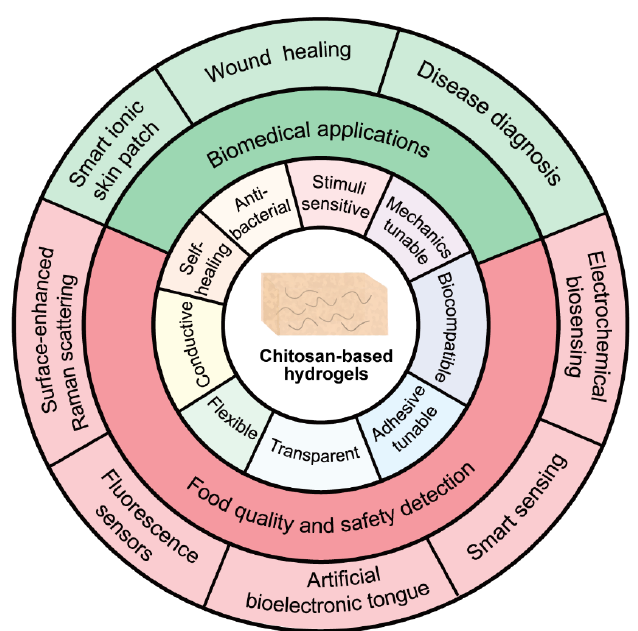
Figure 5. Properties and applications of chitosan ‐ based hydrogels.